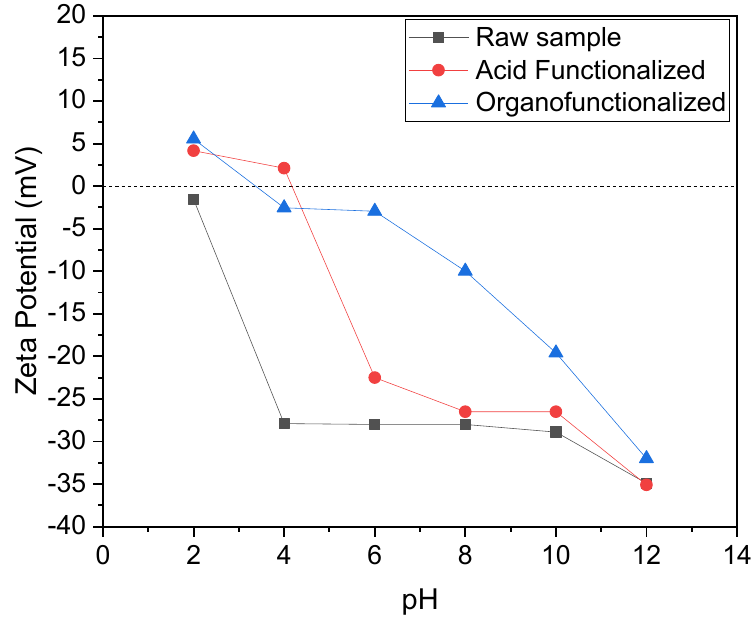
Figure 4. Zeta potential measurements for raw sample and functionalized clays .